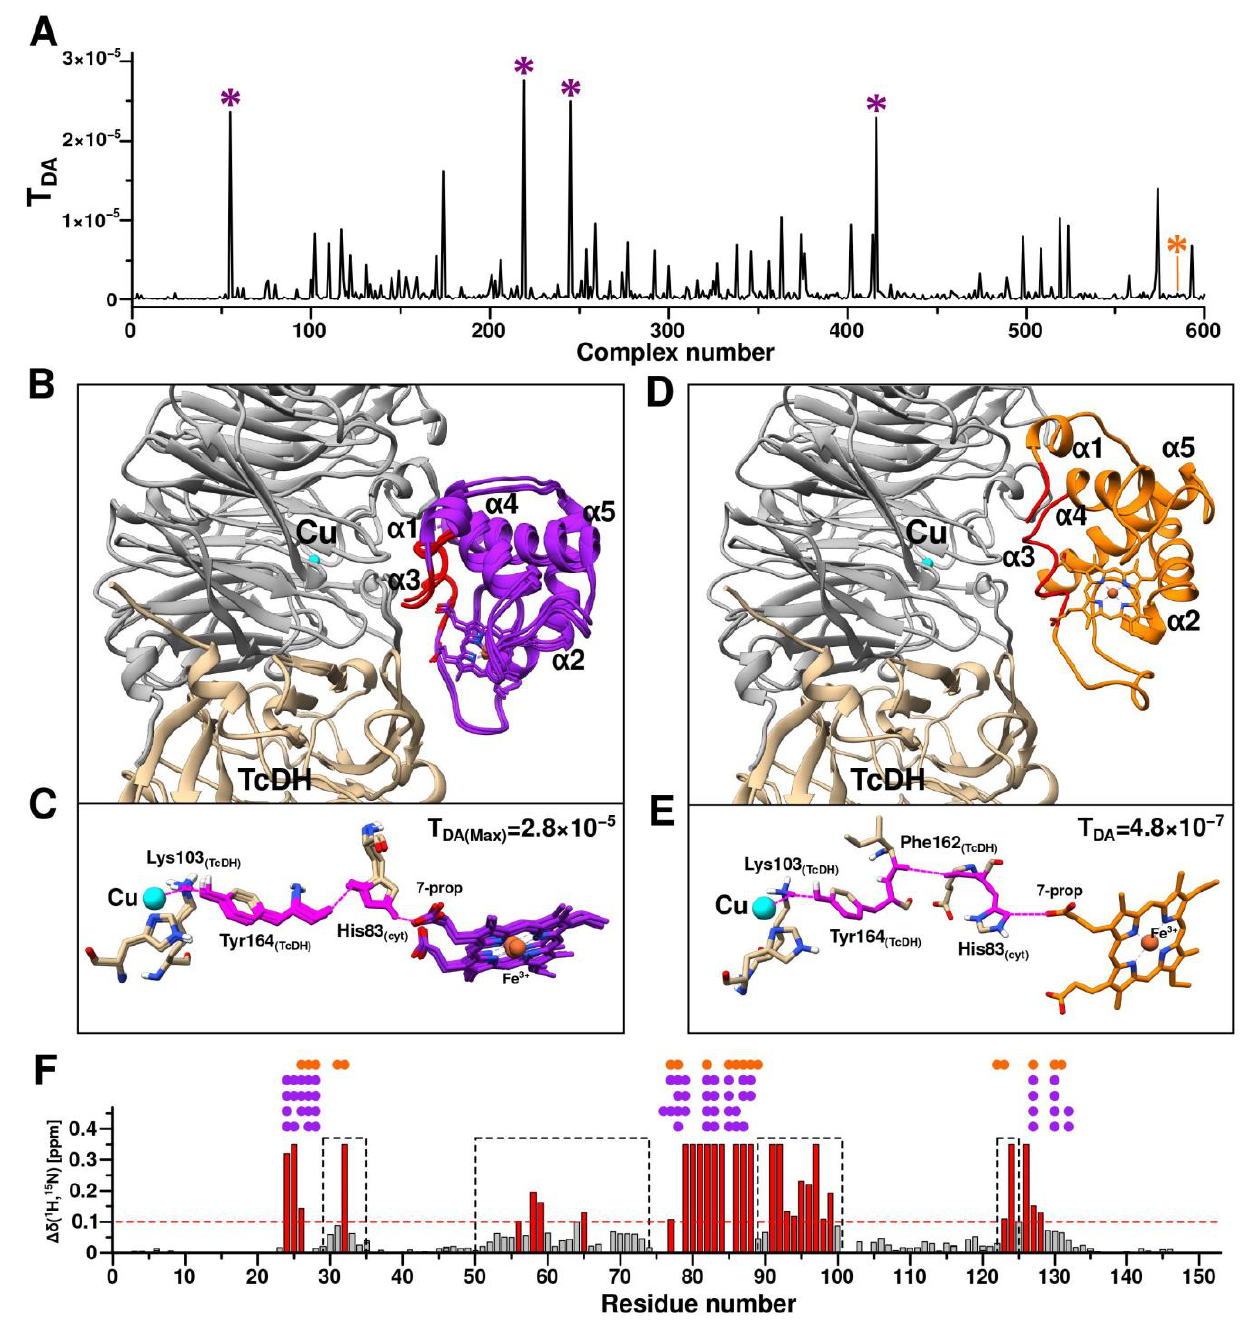
Figure 8. First stage of the TcDH-CytC552 complex structure prediction using HADDOCK (driven by ambiguous restraints (AIRs)) and Pathways program. ( A ) Plot of electron coupling constant (T DA ) depending on structure number from HADDOCK calculations. Violet asterisks indicate the complexes with highest T DA values and the orange asterisk marks the complex with the highest value of the HADDOCK scoring function. ( B ) Aligned structures of the four T DA -best TcDH-CytC552 complexes. TcDH monomers are colored in gray and light brown and CytC552 colored in purple. The exposed CytC552 residues that were used in AIRs generation in the HADDOCK calculations are colored in red. The Cu2 ion of TcDH is colored in cyan. ( C ) Electron transfer (ET) pathways predicted for the four T DA -best TcDH-CytC552 complexes using Pathways (pathcore) program. The ET pathways highlighted in pink: a solid line for transfer through covalent bonds and dotted line for transfer through space or hydrogen bond. ( D ) Haddock structure of TcDH-CytC552 complex with highest value of HADDOCK scoring function. ( E ) The ET pathway for TcDH-CytC552 complex